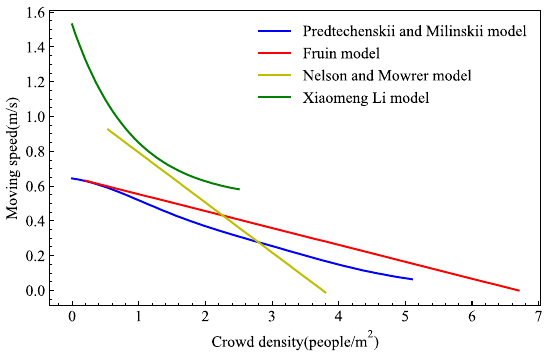
Figure 7. The evacuees’ speed model of descending stairs of various scholars.